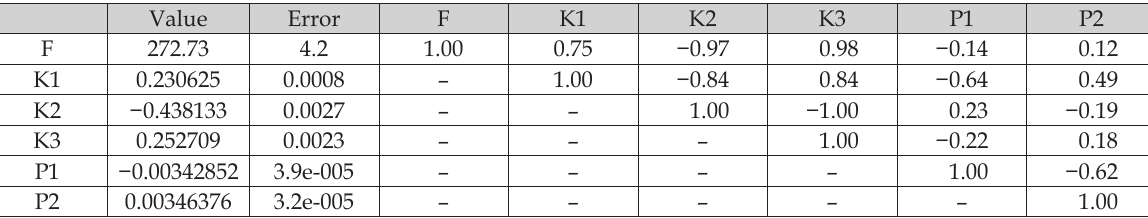
Fig. 6. DEM generated from Agisoft. Table 2. The calibration coefficient and correlation